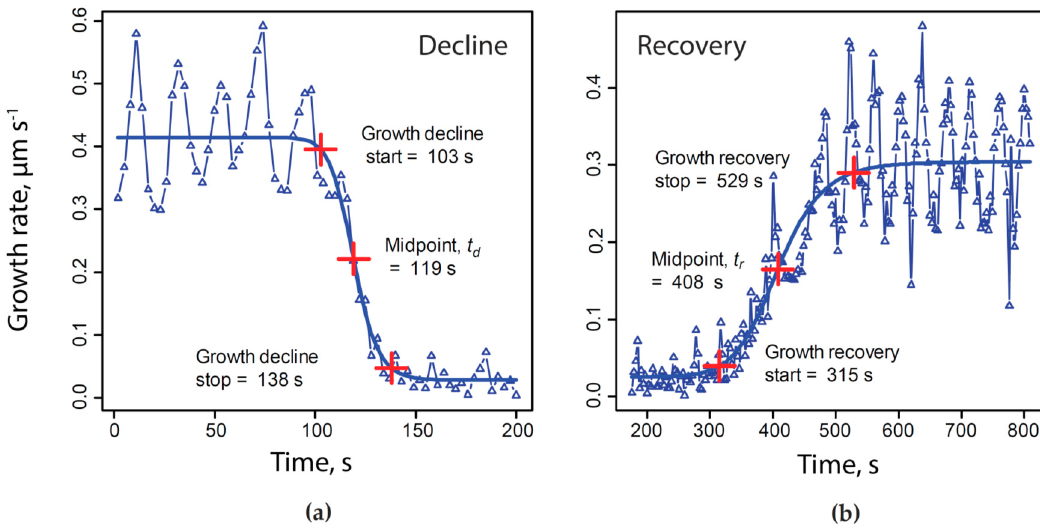
Figure 1. Growth response to potassium cyanide (KCN) inhibition and time base normalization— determination of a normalized time base for each experiment, based upon growth rate patterns. Four parameter logistic curves were fitted to the decline (a) and recovery (b) of growth caused by transient exposure to and removal of 200 µM KCN. The times corresponding to each frame of each time-lapse sequence were first offset to set the midpoint of growth decline (Figure 1a, t d ) to zero, and then were divided by the span of growth inhibition, t r − t d . Time points corresponding to 5 and 95 percent of growth (or other measurements) range were also recorded and averaged as an estimate of the initial time, duration and completion of each phase of the response to KCN.